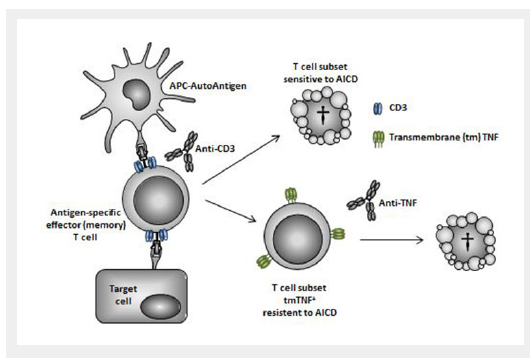
Schematic representation of a possible complementary mechanism of action for anti-CD3 and anti-TNF combination therapy on pathogenic T cells. In response to antigen presentation and exposure to anti-CD3 mAb in the secondary lymphoid and target organs, antigen-specific effector and/or effector memory T cells either undergo apoptosis through the process of activation-induced cell death (AICD) or survive and express several activation markers, including transmembrane (tm) TNF. An anti-TNF mAb can then deplete by ADCC (and/or reverse signalling) pathogenic T cells resistant to anti-CD3 induced